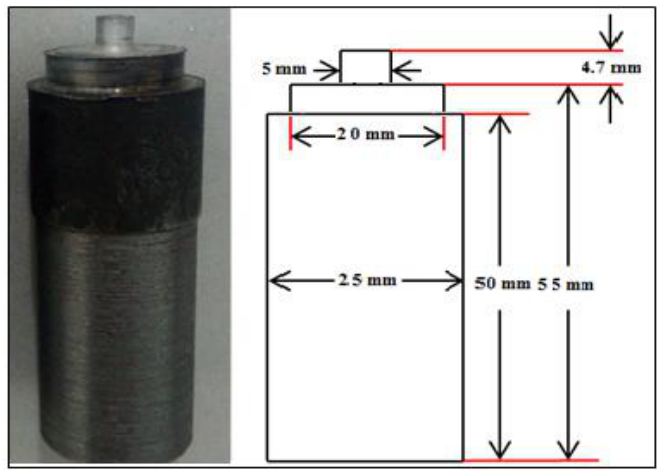
Figure 3. The tool used in FSW and P-FSW processes.